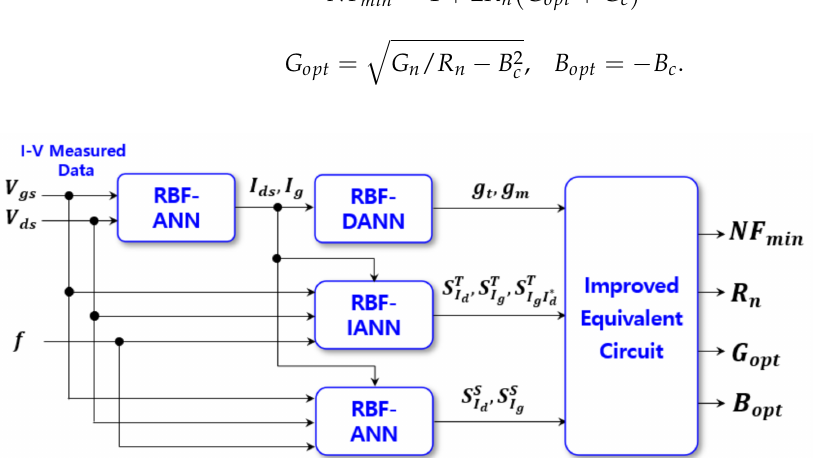
Figure 3. ANN (artificial neural networks) -based noise modeling for the estimation of HF (high frequency) noise